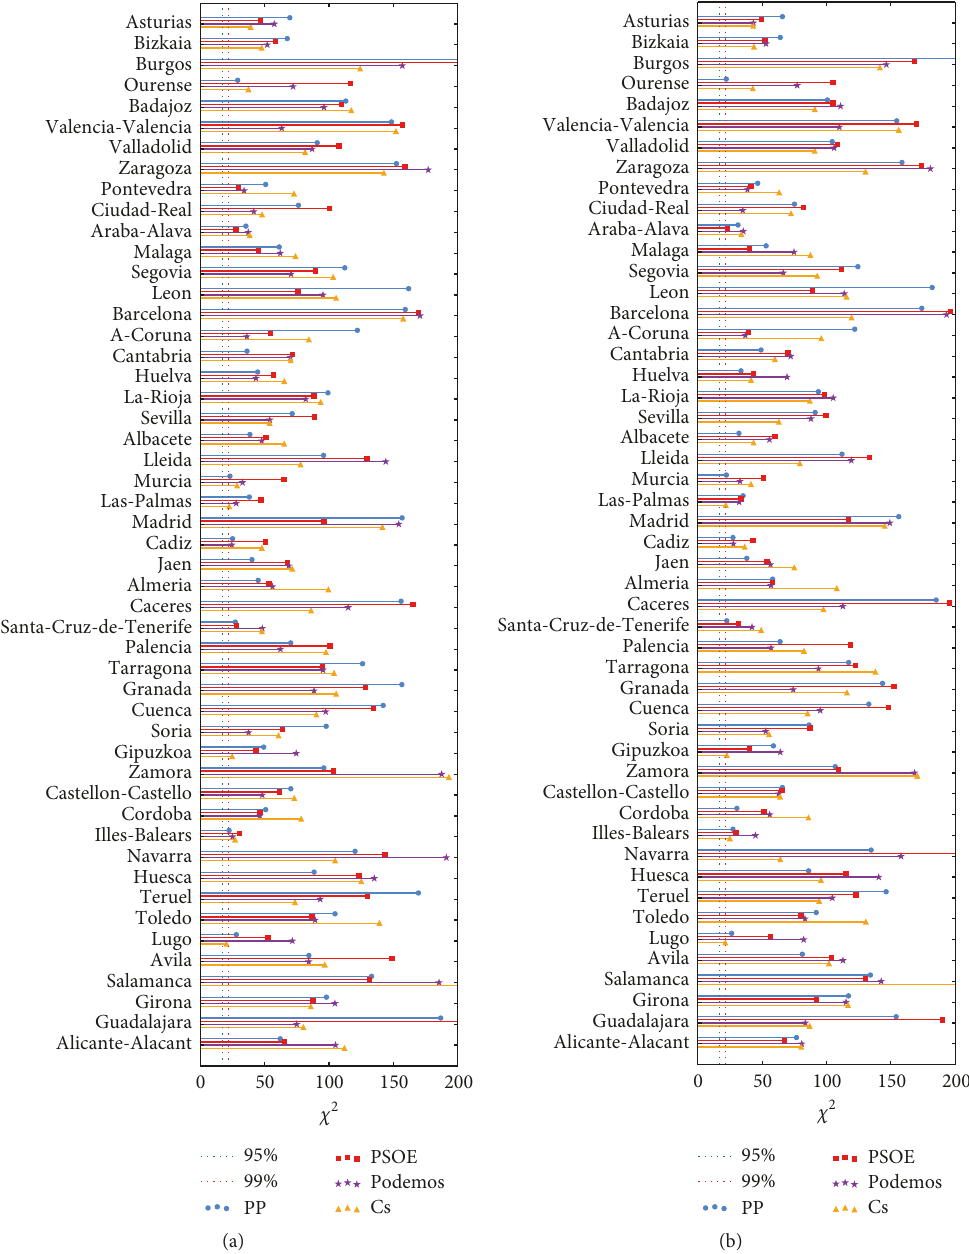
Figure 21: 𝜒 2 values of the goodness of fit to 2BL for 2015 (a) and 2016 (b) at the aggregation level of precincts. In every case, the critical values for rejection at the 95 and 99% confidence level are shown. Virtually in all cases the null hypothesis is rejected. All these results are consistent with the hypothesis test based on MAD reported in Figure